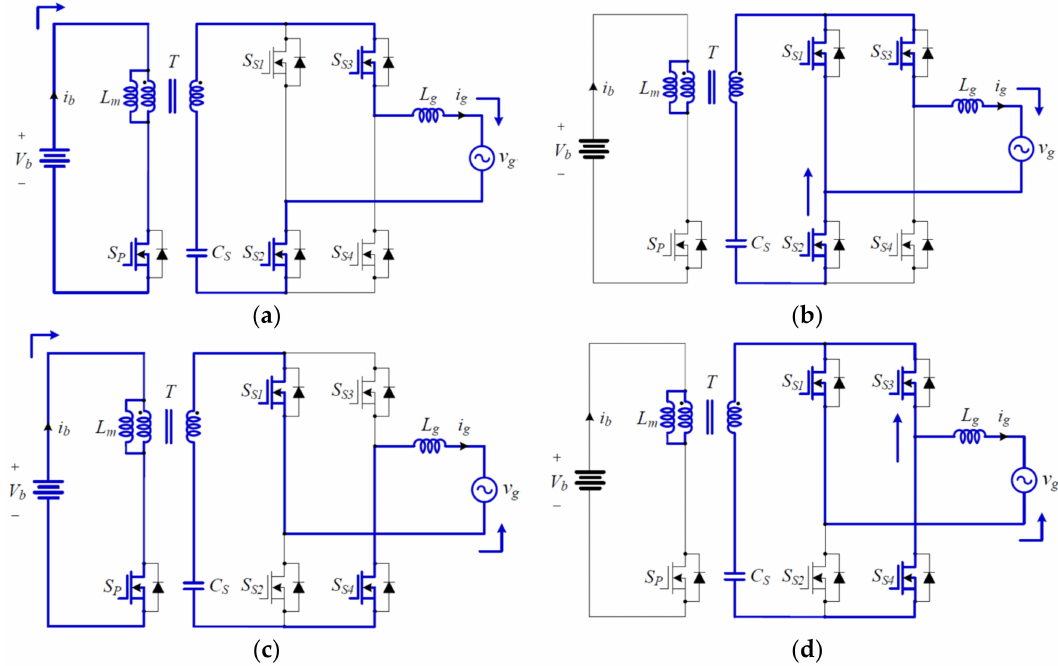
Figure 2. Switching states in the inverter mode: ( a ) state 1 for the positive grid voltage; ( b ) state 2 for the positive grid voltage; ( c ) state 3 for the negative grid voltage; ( d ) state 4 for the negative grid